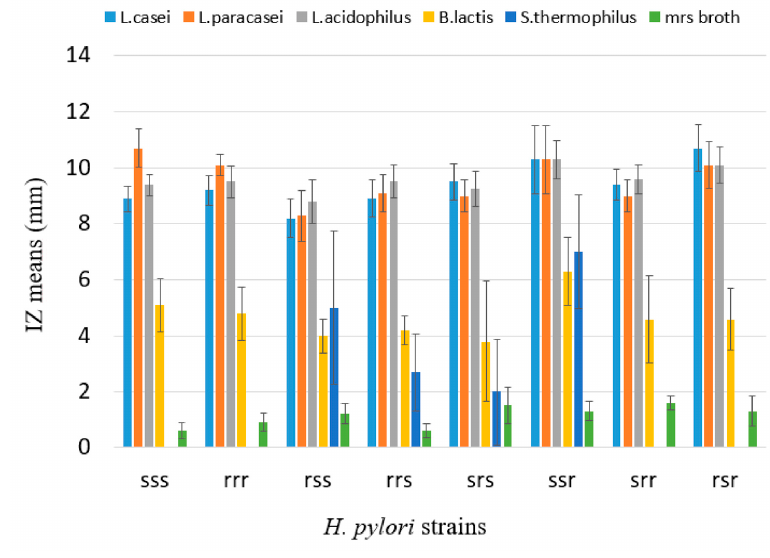
Figure 2. IZ means (and standard errors) in the eight H. pylori groups with di ff erent resistance patterns. S: susceptible. R: resistant. Resistance patterns are reported in this order: clarithromycin, metronidazole, levofloxacin. BHI broth never produced an IZ. IZs do not correlate with H. pylori pattern of antibiotic resistance. IZ distributions and means of the same probiotic strain vs. the eight di ff erent H. pylori groups were analyzed using ANOVA and Student’s t -test; no statistically significant di ff erence was detected. Di ff erences of IZ means were still significant between the probiotic strains as previously reported: L. casei = L. paracasei = L. acidophilus > B. lactis > S. thermophiles > negative